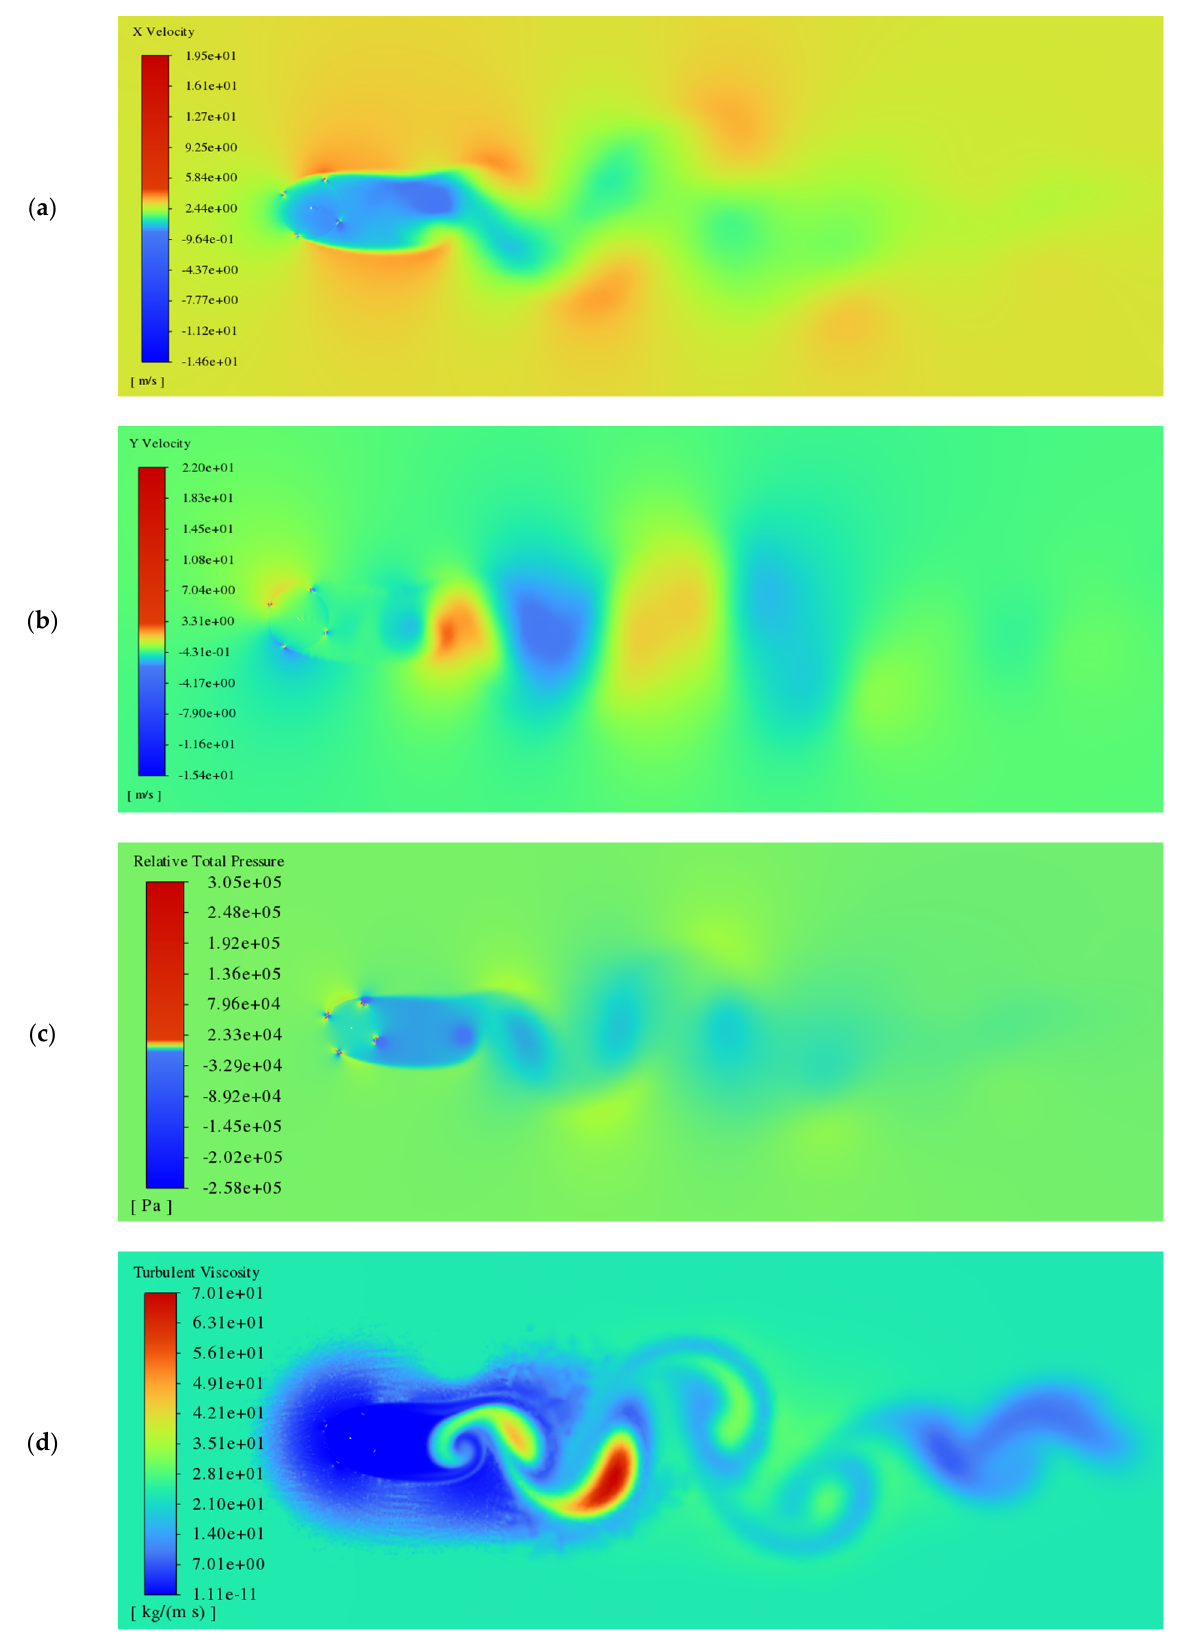
Figure 17. Turbine wake field at v ∞ = 3.0 m/s, for the variables of ( a ) x-velocity, ( b ) y-velocity, ( c ) relative total pressure, and ( d ) turbulent viscosity.